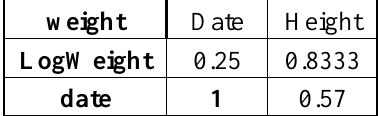
Table 11. Similarity matrix for the sets of neighbors of weight .